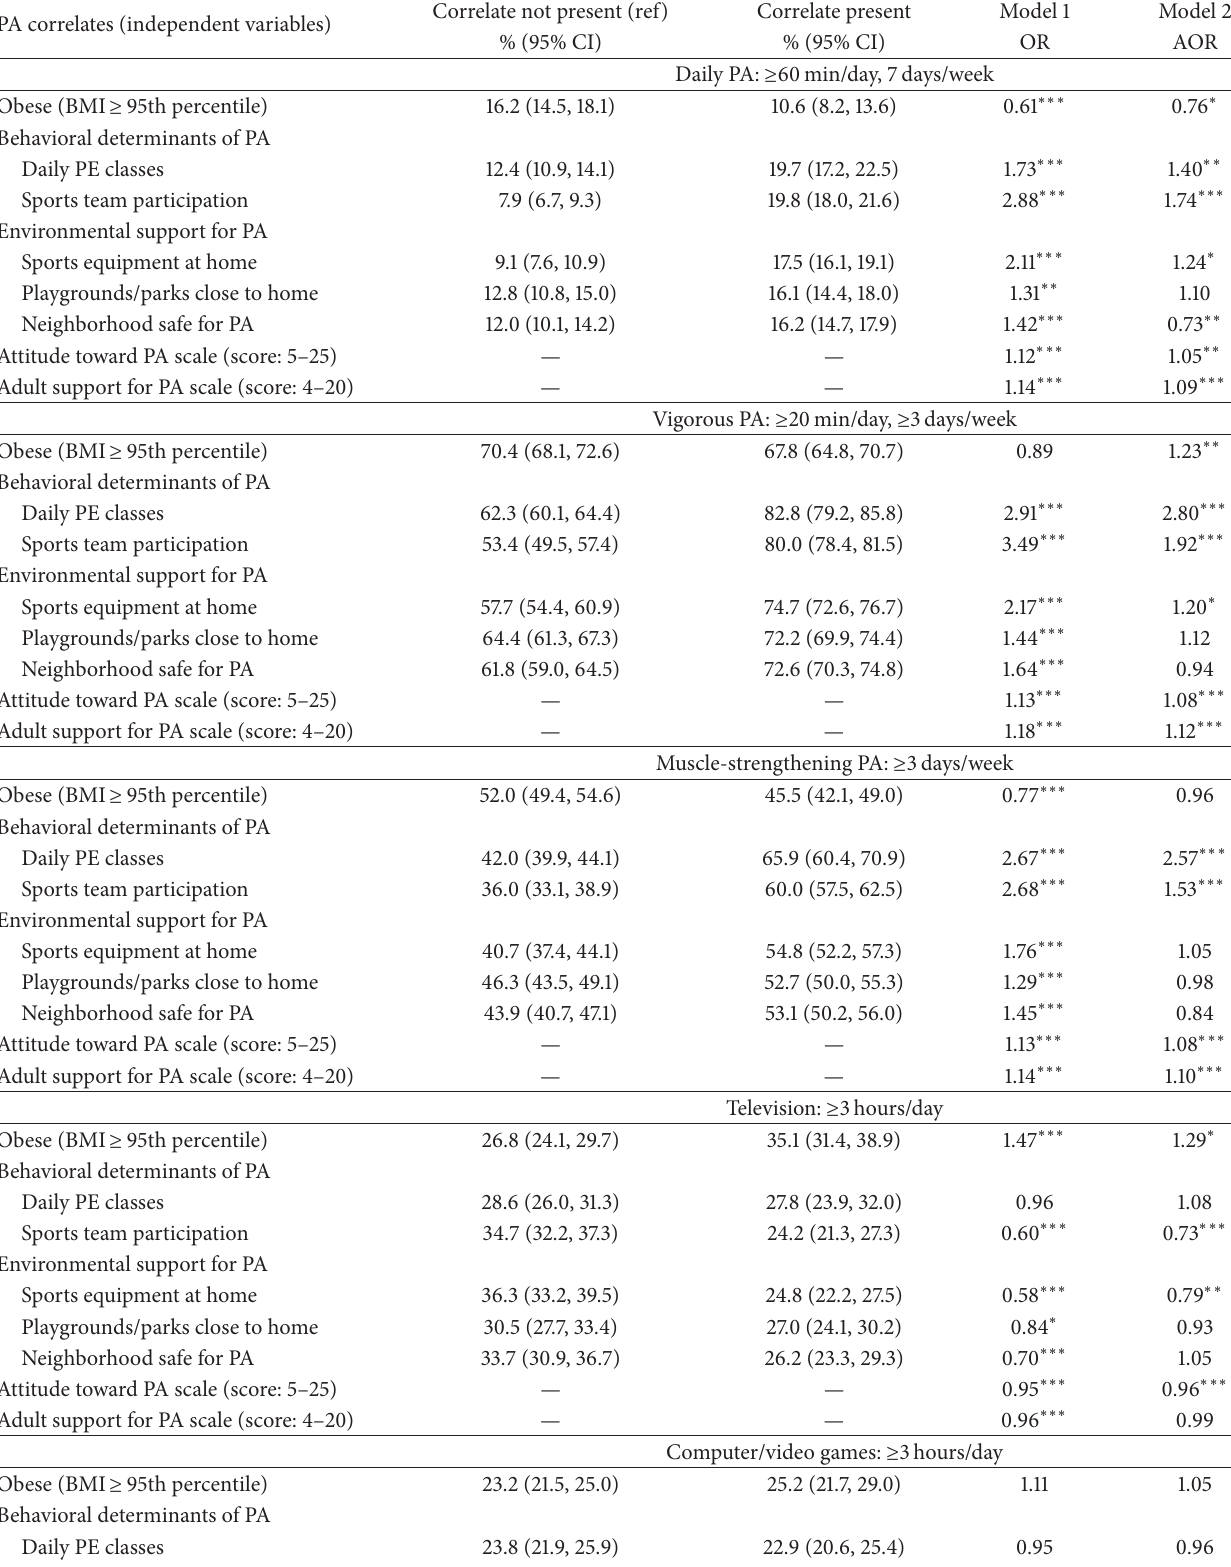
Table 4: Prevalence, unadjusted (Model 1), and adjusted (Model 2) associations between physical activity (PA) correlates and PA and sedentary behaviors among US high school